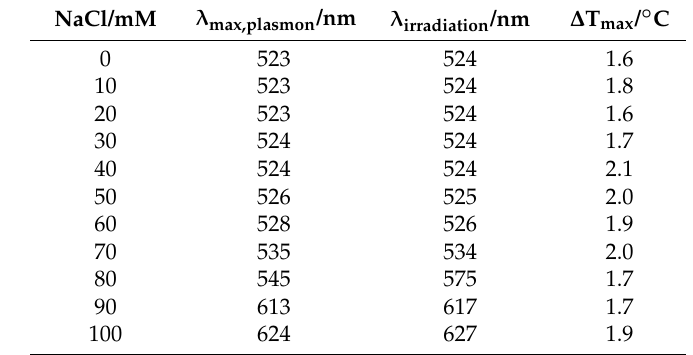
Table 1. Values of maximum wavelength for the plasmon peak of the gold nanoparticles ( λ max,plasmon ), wavelength of incoming light during photothermal experiments ( λ irradiation ), and final increase of temperature during photothermal experiments ( ∆ T max , standard deviation equal to or lower than 5%) for the different values of ionic strength.